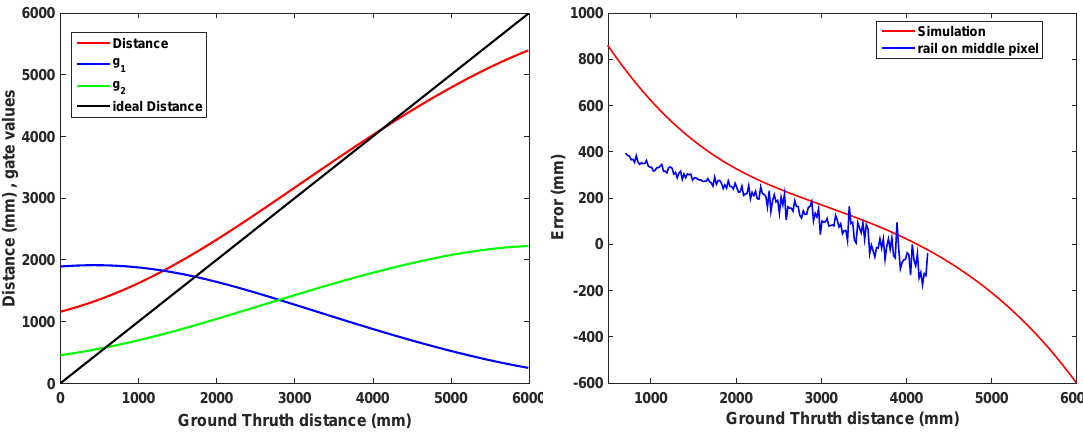
Figure 17. Simulated distance (left) comparison of distance error on simulated and rail measurement